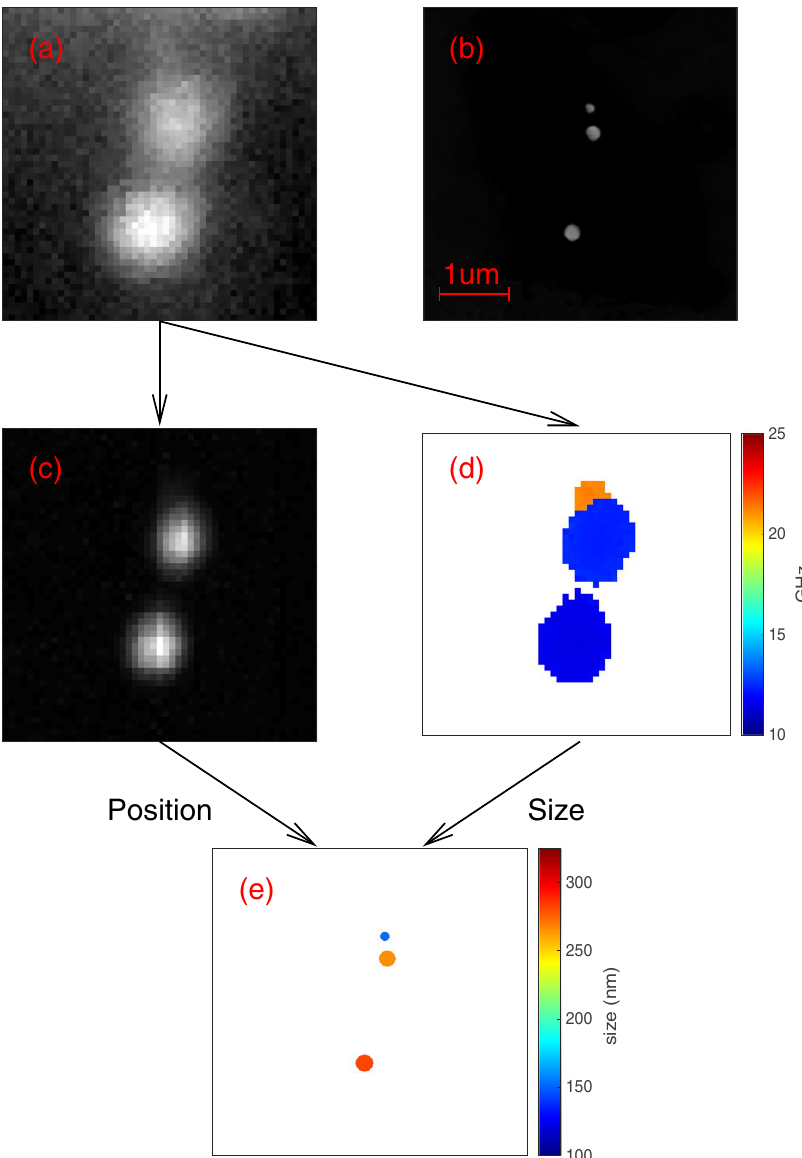
Figure 4. Images of three particles. ( a ) Optical image, ( b ) SEM, ( c ) acoustic amplitude, ( d ) acoustic frequency and ( e ) localisation of the particles with better precision than the diffraction limit. One is well separated from the others and can easily be resolved optically. The other two are ~200 nm apart and cannot be resolved optically, however, the acoustic signals clearly identifies the size and location of the particles allowing accurate reconstruction of the image shown in the